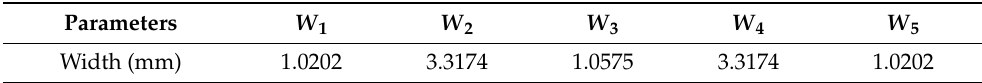
Table 6. Actual width of sin + 3rd harmonic modulated magnetic pole under one pole.